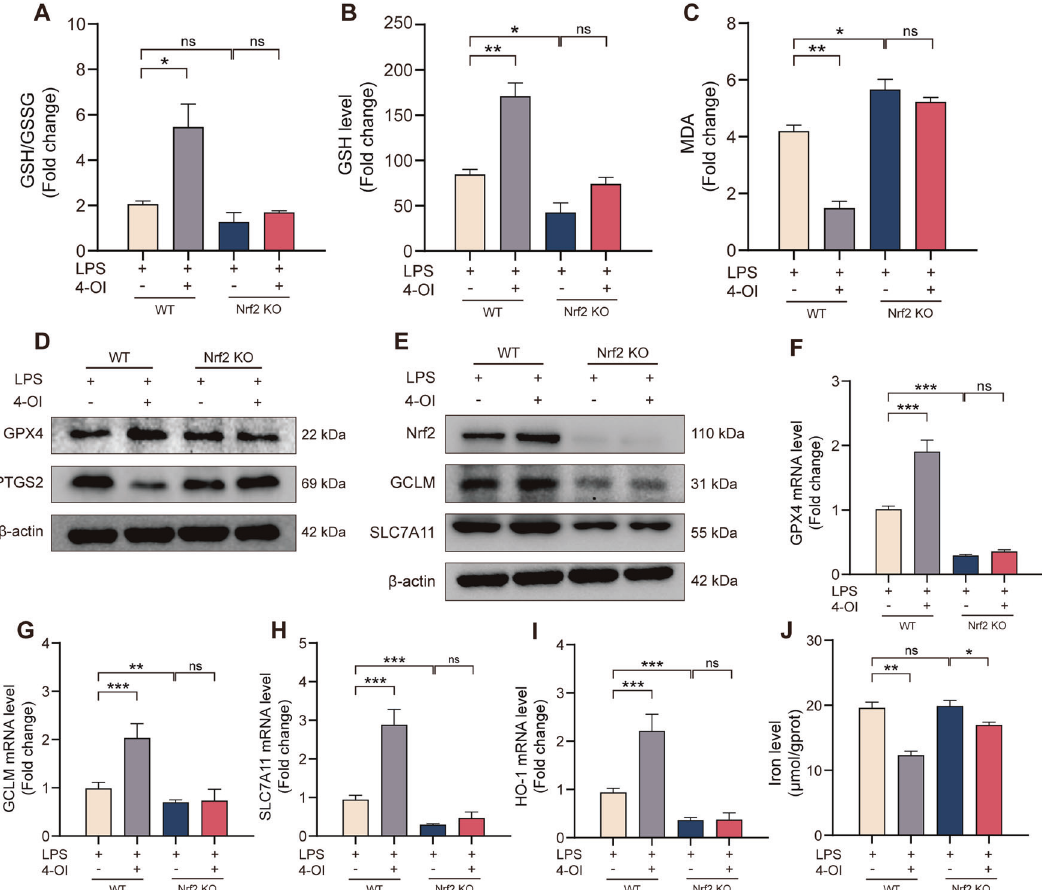
Fig. 6 The inhibition of 4-OI for ferroptosis was abolished in Nrf2-KO mice. A – C Relative GSH, GSH/GSSG ratio and MDA levels in murine lung tissue ( n = 6). D , E Western blots for GPX4, PTGS2, Nrf2, GCLM and SLC7A11 in murine lung tissue. F – I Relative mRNA levels of GPX4, GCLM, SLC7A11 and HO-1 in murine lung tissue ( n = 6). J Relative iron levels of murine lung tissue ( n = 6). (Data are presented as Mean ± SD * p < 0.05, ** p < 0.01, *** p <